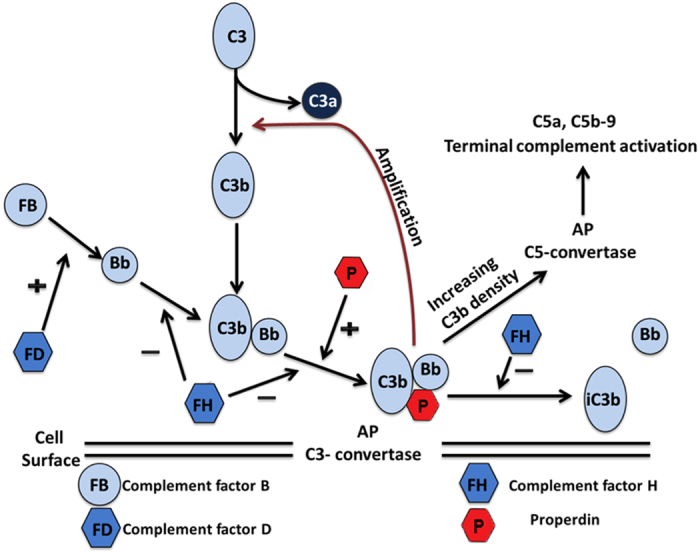
Activation of the alternative complement pathway.The figure summarizes the activation of the alternative pathway with the main components C3 and factor B (FB), the activator of FB, factor D (FD), and the regulators of AP activation: the inhibitor factor H (FH) and the enhancer properdin.